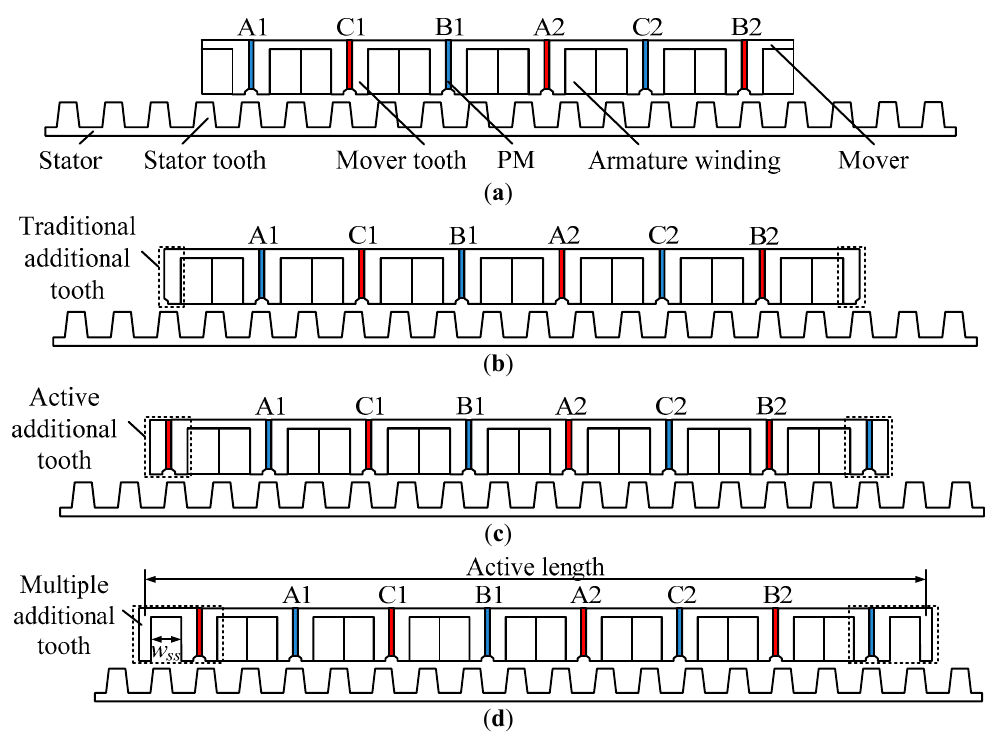
Figure 2. C-core linear flux-switching permanent magnet machine configurations. ( a ) Without additional tooth, Machine I; ( b ) with traditional passive additional tooth, Machine II; ( c ) with active additional tooth, Machine III; ( d ) with multiple additional tooth, Machine IV.